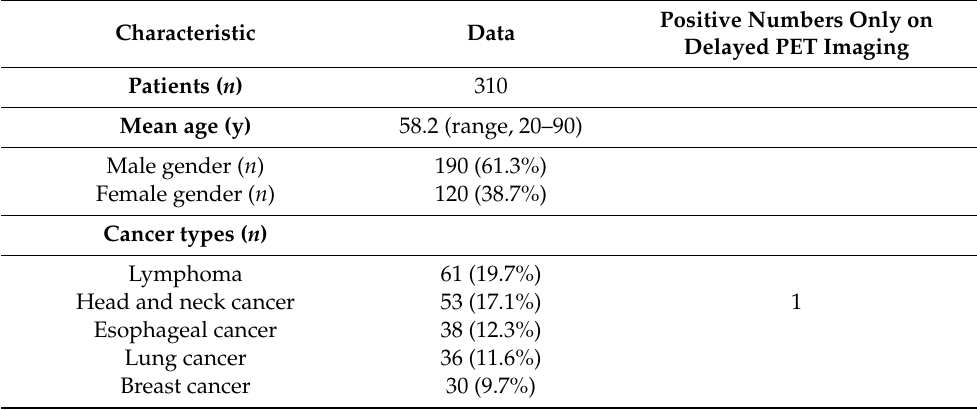
Table 1. Patient